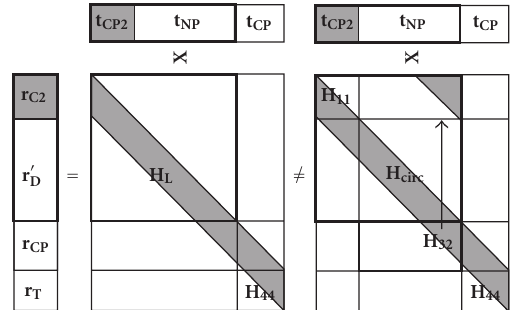
Figure 9: The circulant matrix H circ is a result of channel convolution and additive correction. Caution: r C2 is part of r (cid:4) D